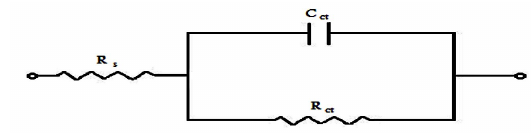
Figure 4. Proposal electrical equivalent circuit used for metal/ solution interface.